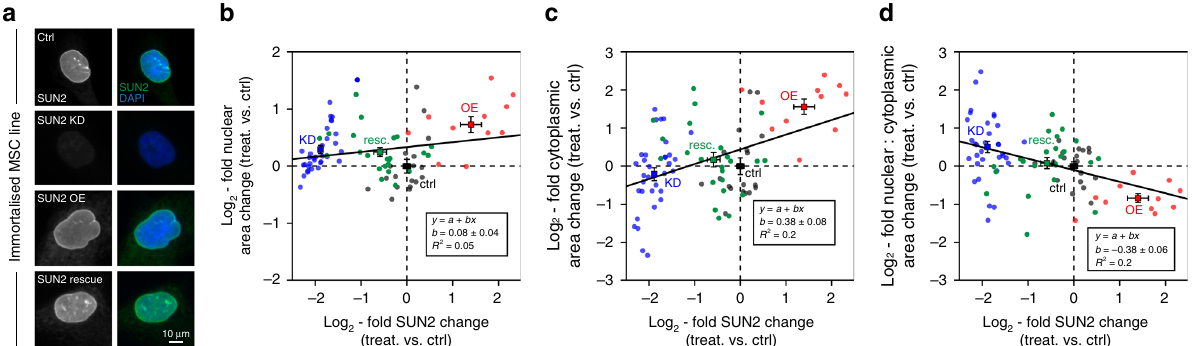
Fig. 7 Cell and nuclear areas are both affected by perturbation to SUN2 levels. a Representative images of immortalized MSC nuclei stained against DAPI and SUN2 following control, SUN2 KD (siRNA2), OE and rescue (OE + siRNA2) treatments. Scatter plots showing log 2 -fold change to b nuclear area, c cytoplasmic area, and d nuclear to cytoplasmic area ratio vs. log 2 -fold change to SUN2 expression, in immortalized MSC nuclei (control, SUN2 KD, OE, and rescue), relative to control levels. Data points indicate individual nuclei ( ≥ 11 analysed per condition); annotated points show mean ± s.e.m. for each condition; lines show linear regression analysis (with annotation of gradient, b ± standard deviation). See Supplementary Fig. 10b – e for data distributions and statistics. Nuclear area showed weak positive power law scaling with SUN2 expression ( b = 0.08 ± 0.04). However, as the cytoplasmic area showed stronger scaling with SUN2 expression ( b = 0.38 ± 0.08), the nuclear to cytoplasmic area ratio had overall negative scaling ( b = − 0.38 ± 0.06). These results suggest a pronounced inside-to-outside in fl uence of SUN2 levels on the